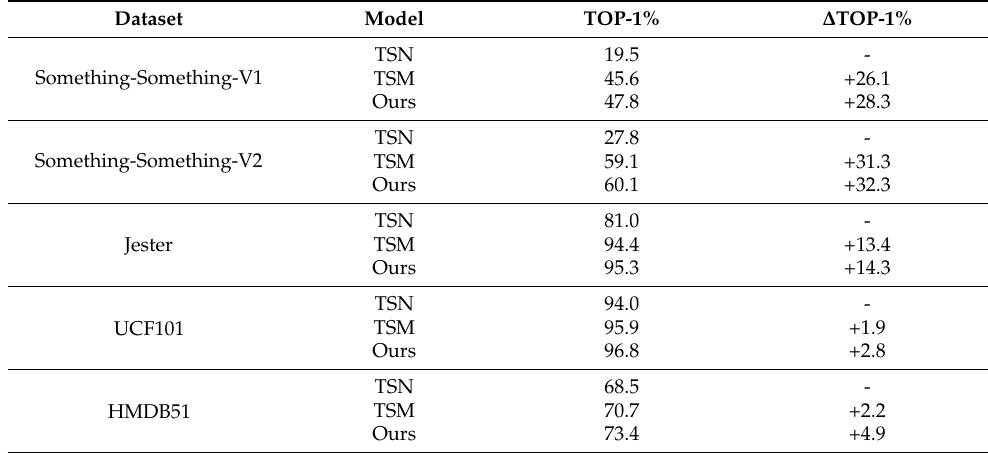
Table 2. Comparison with baseline on three